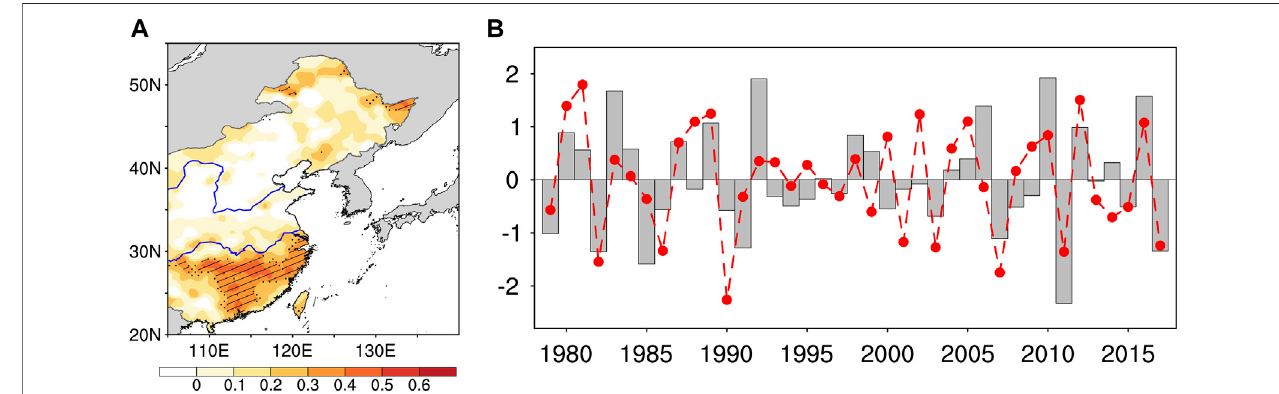
FIGURE 10 | (A) Distribution of temporal correlation coef fi cient of SEPF in East China between the observation and hindcast. Regions with stippled and hatched patterns indicate that the correlations are signi fi cant at the 90 and 95% con fi dence levels, respectively. (B) Time series of the normalized SC_SEPI (bars) and the hindcasted SC_SEPI calculated using the leave-one-out cross-validation method based on the preceding October SNOWI (red line).